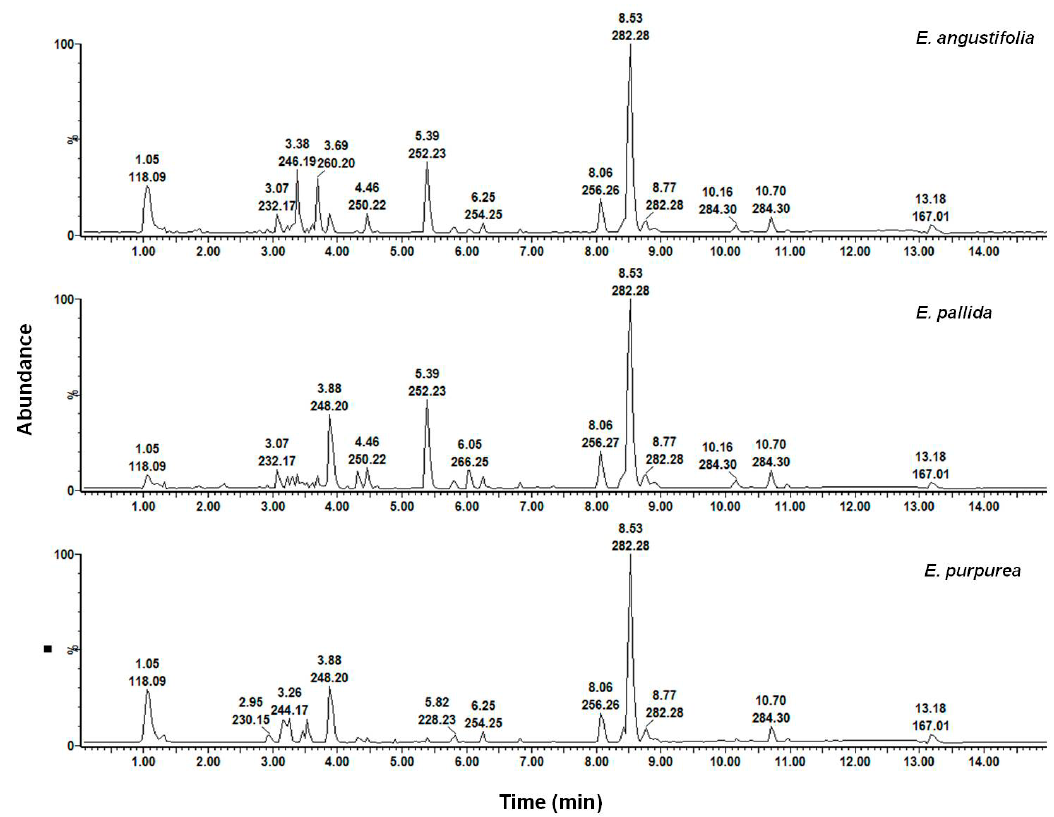
Figure 10. Chromatographic fingerprints of methanol root extracts of Echinacea